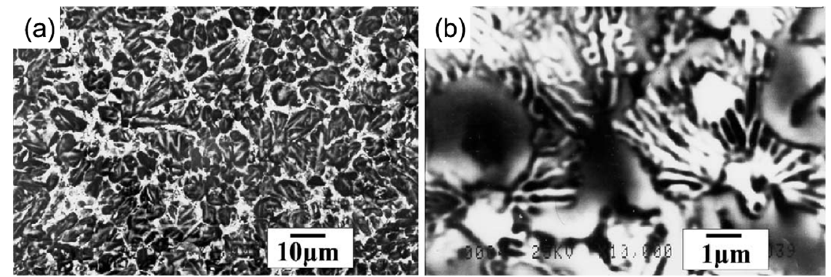
Figure 8. ( a ) SEM micrograph of the alloyed zone. The former austenite grains transformed on cooling to martensite (gray) and are surrounded by globular M 6 C carbides and a eutectic mixture containing M 2 C carbides (white areas); ( b ) SEM showing, in detail, the microstructure of Figure 6a. Dark gray areas are former austenite grains transformed to martensite and are separated by a duplex M 6 C/ γ and M 2 C/ γ eutectic. Globular white particles are M 6 C carbides, from which the M 2 C carbides are radially emanating [54].